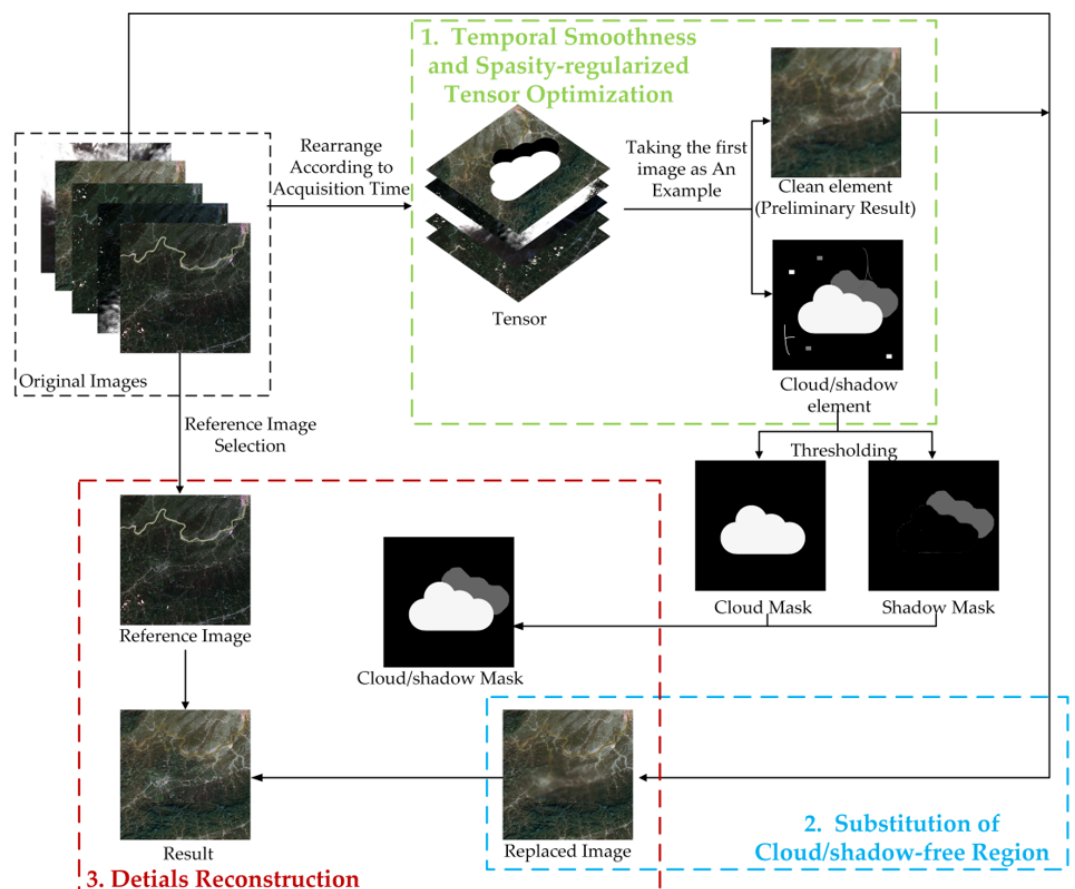
Figure 1. Flowchart of the proposed Temporal Smoothness and Sparsity-regularized Tensor Optimization (TSSTO)